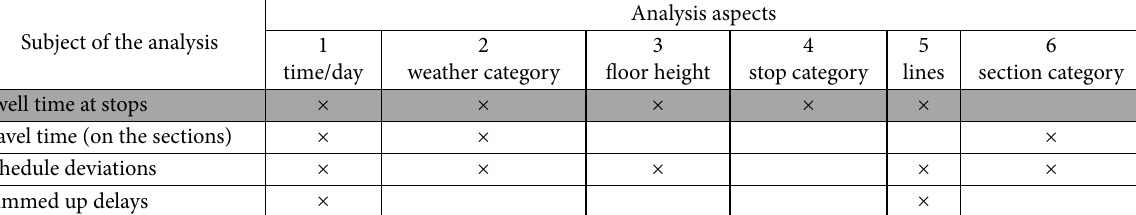
Table 5. Subject of the analysis – analysis aspects matrix ( source : research by the authors) Subject of the